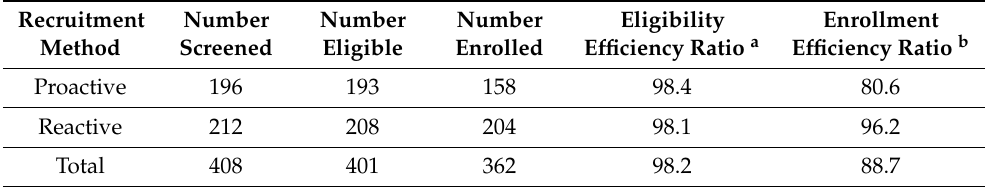
Table 1. Efficiency ratios for proactive and reactive recruitment methods.